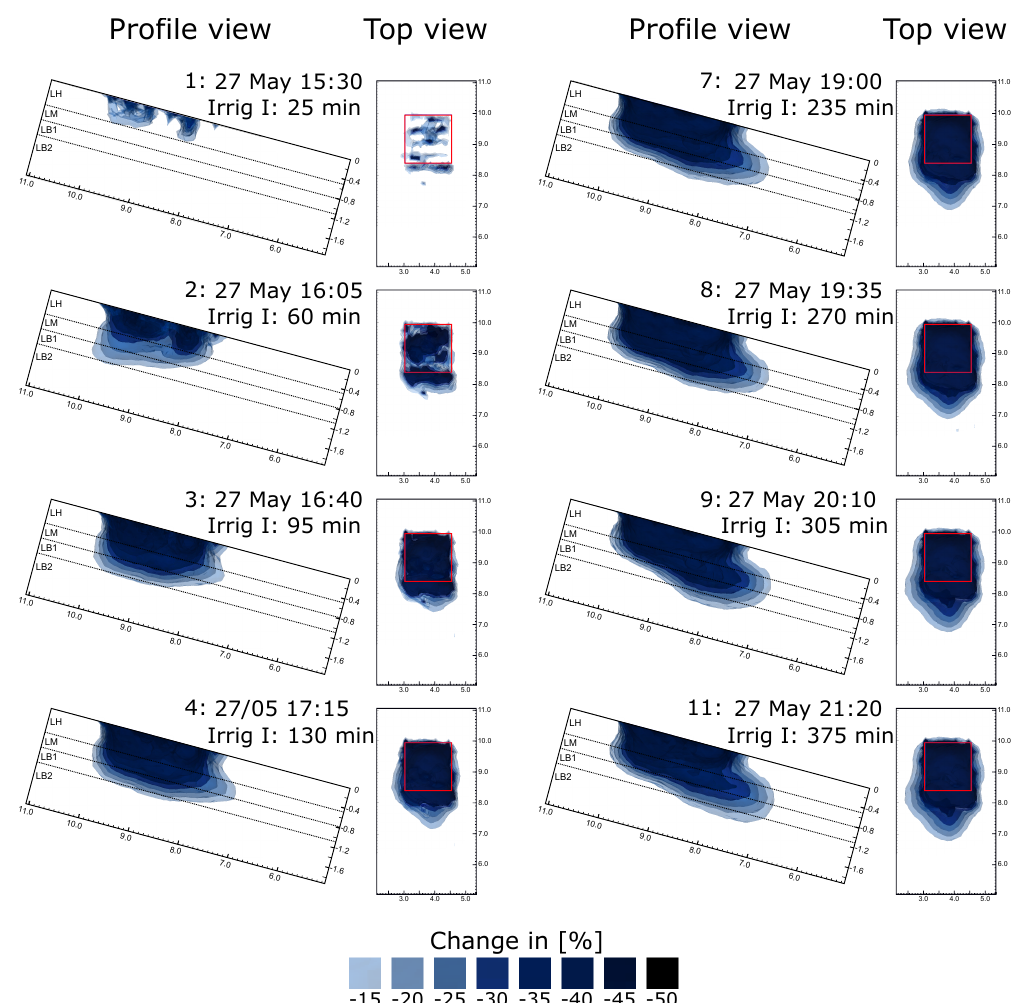
Figure 6. Spatial distribution of resistivity change (profile and top view of the 3-D model with transparent isosurfaces and a threshold of 15%) for selected time steps during the first